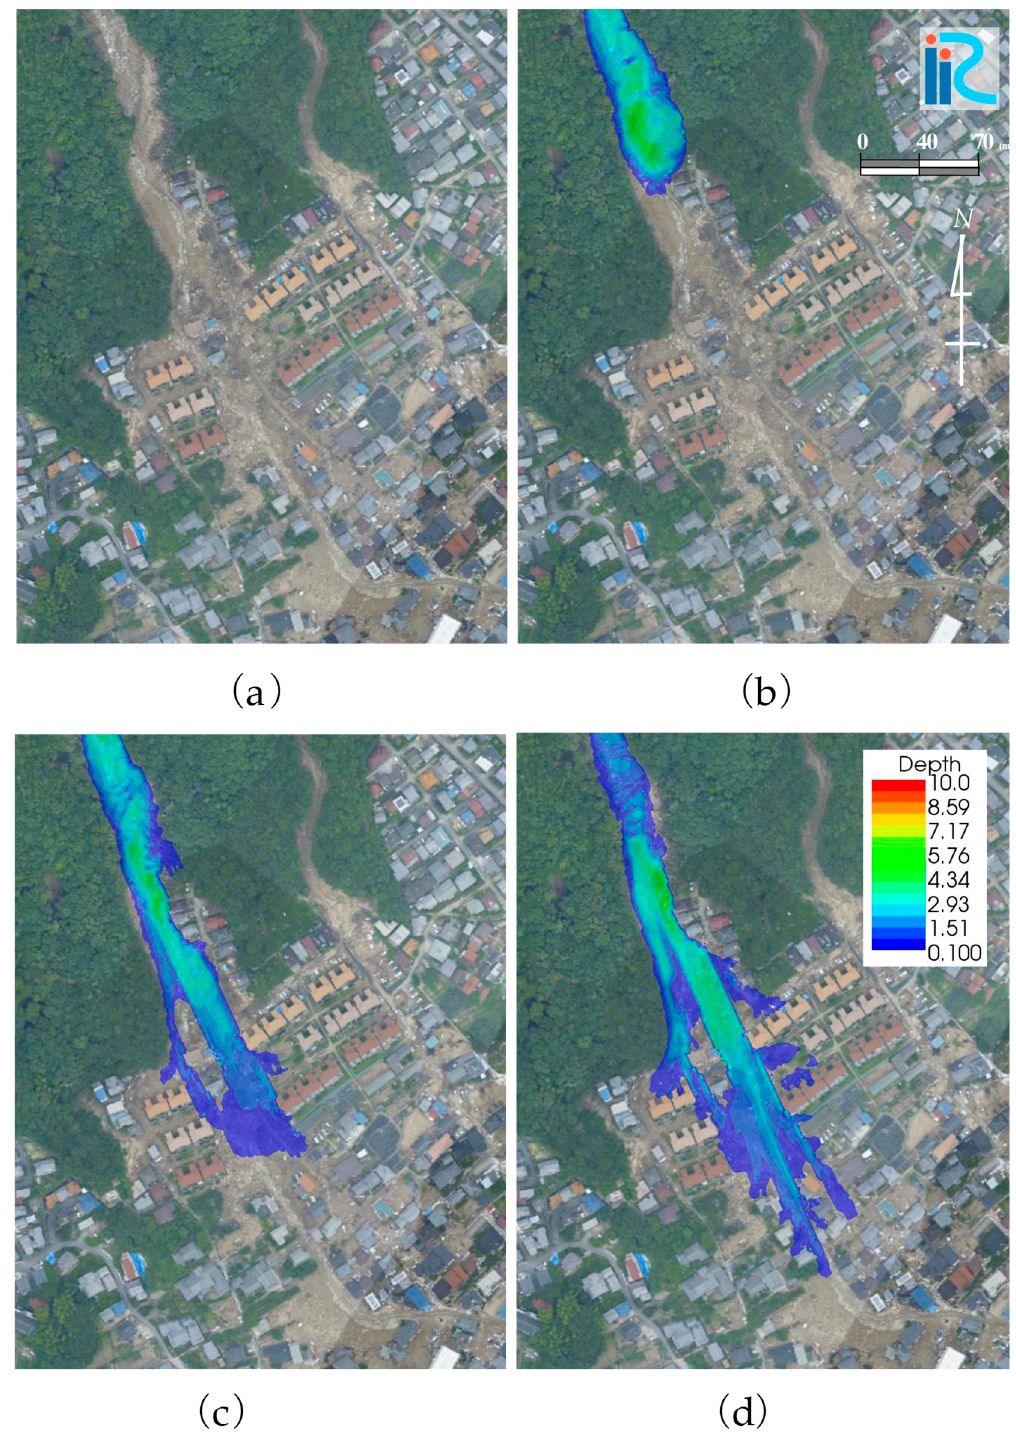
Figure 16. Case 1: Spatiotemporal change in debris flow depth in the residential area. Houses and buildings were considered in the analysis. ( a ), ( b ), ( c ), and ( d ) show the flow depth at 5s, 43s, 105s, and 200s, respectively.